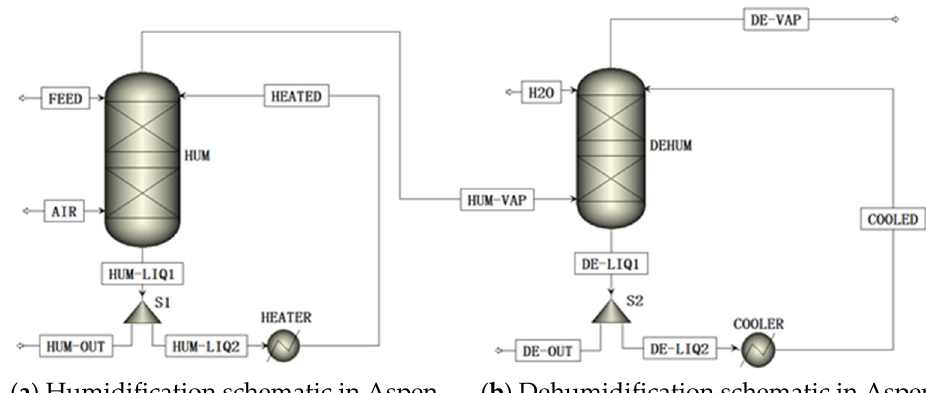
Figure 1. Overall HDH schematic in Aspen Plus.